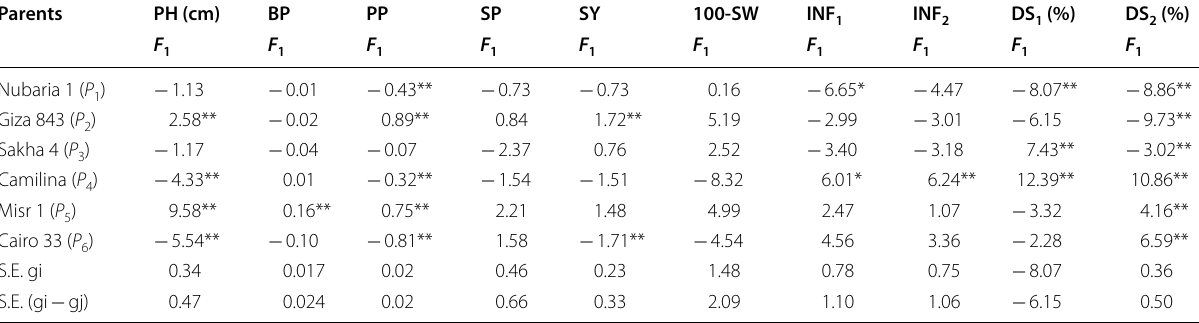
* and ** indicate significant and highly significant at 0.05 and 0.01 level of probability, respectively Table 6 Estimates of the specific combining ability effects ( S Cross PH (cm) BP